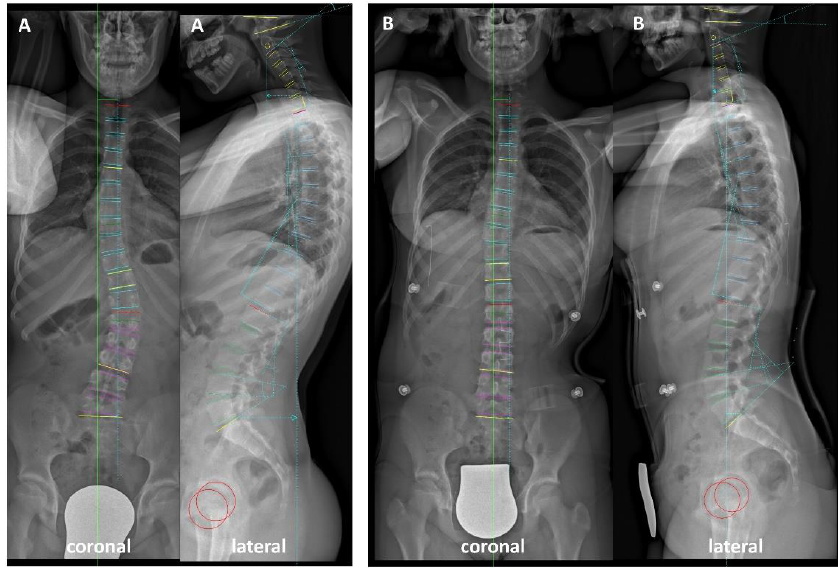
Figure 2. ( A ) Pre- and ( B ) in-brace coronal and lateral radiographs illustrating the analyzed spinal parameters.